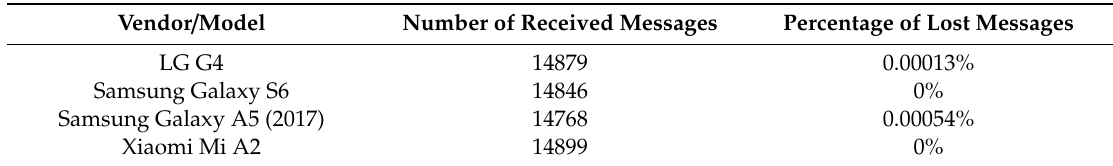
Table 4. Number of received and lost messages per smartphone model. Tests were driven using a sensor module (with a sensing period of 20 ms) and running the YouTube app at the same